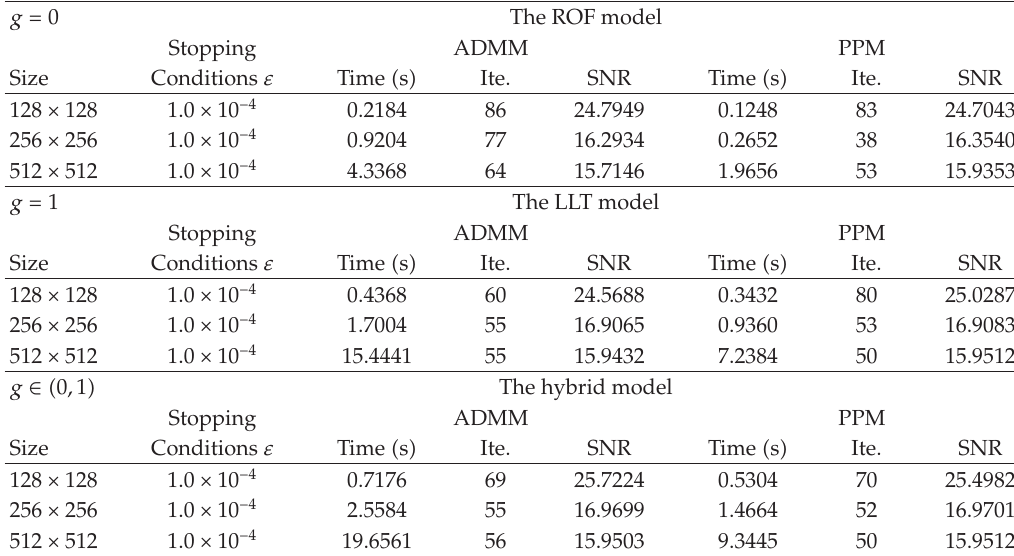
Table 1: The related results in Example 4.7.